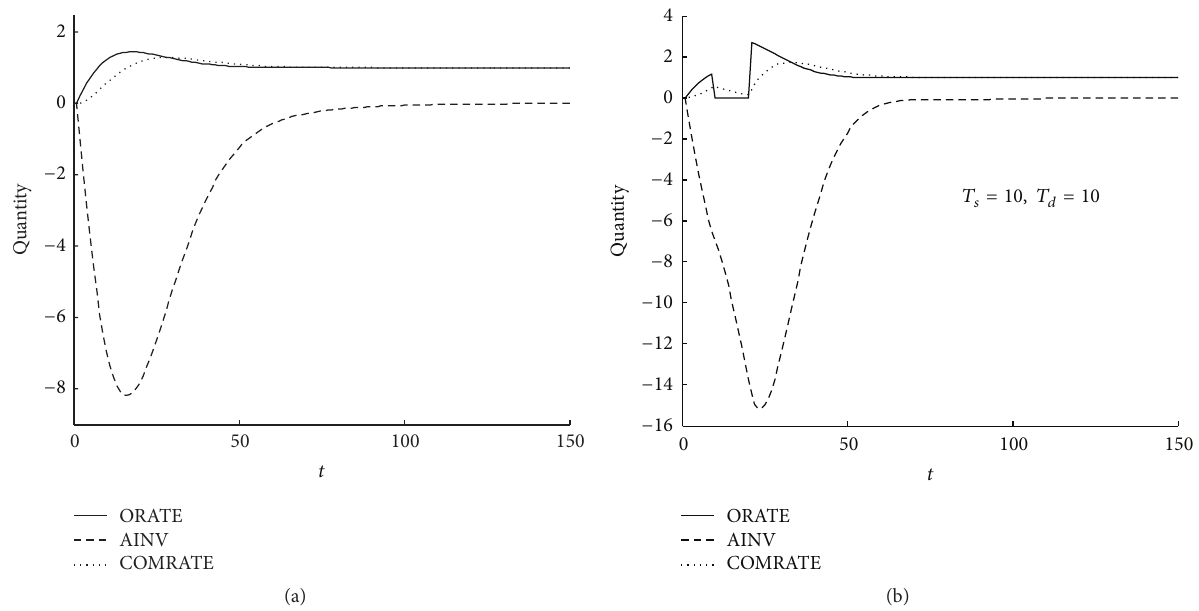
Figure 3: Two cases without and with supply disruption under demand disruption.